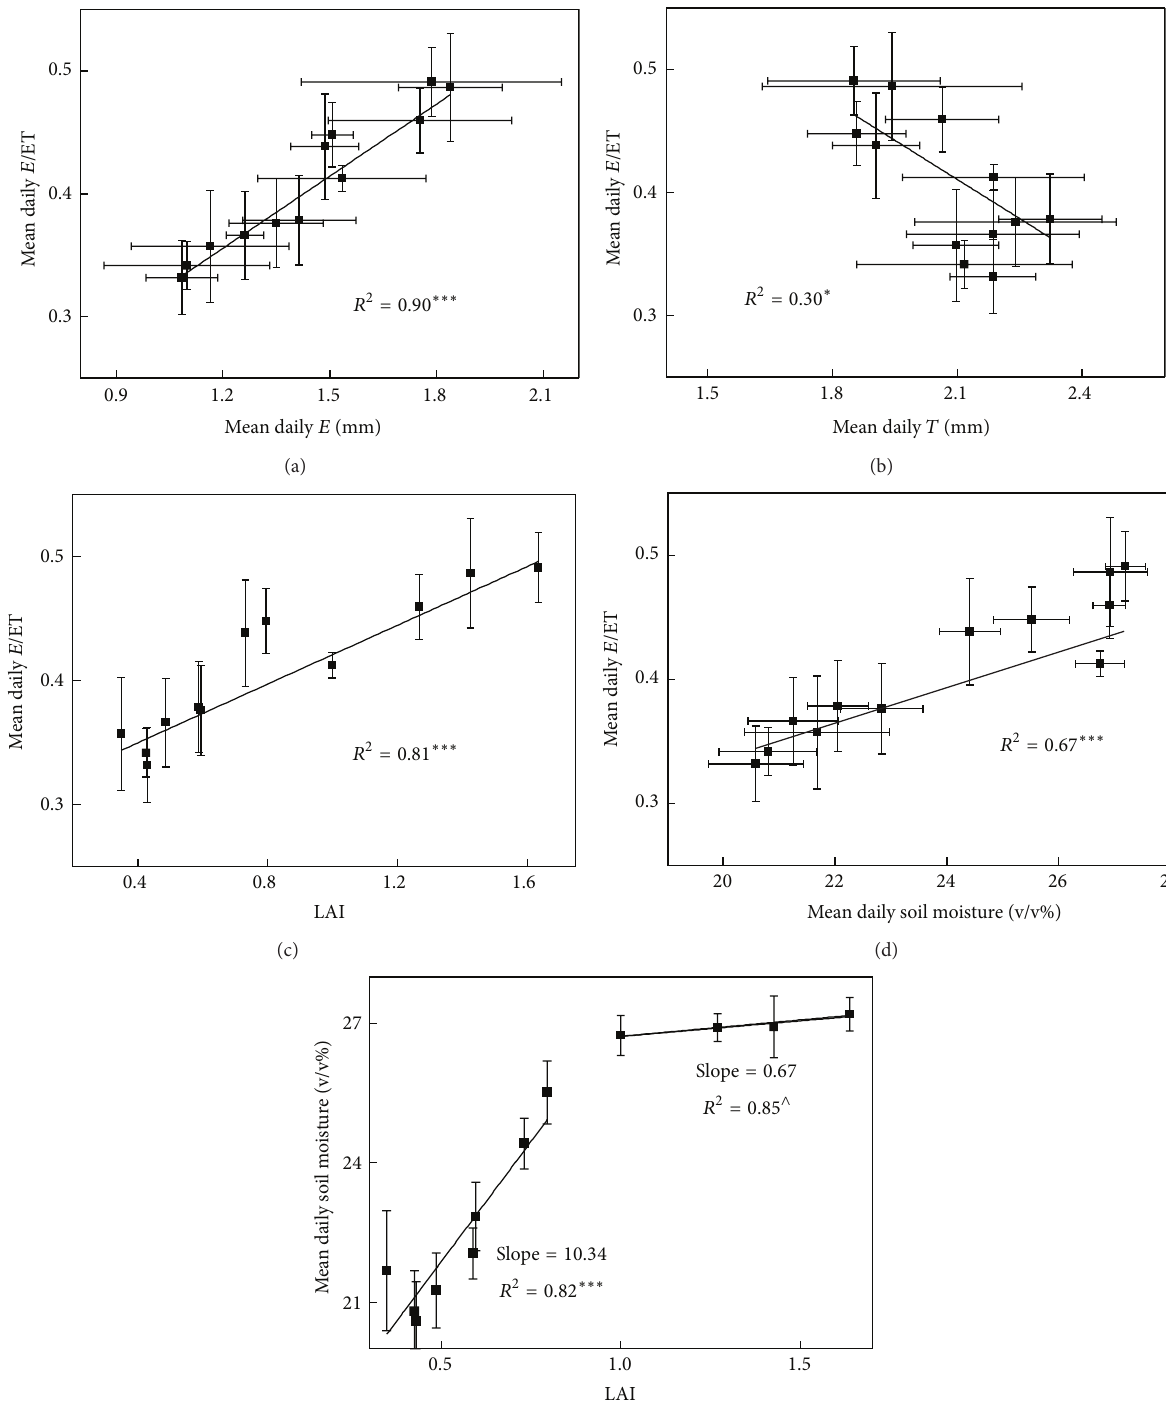
Figure 7: Relationships between mean daily E/ET and mean daily (a) E, (b) T, (c) LAI, and (d) soil moisture and (e) the relationship between LAI and mean daily soil moisture. ∧ 𝑃 > 0.05 ; ∗ 𝑃 < 0.05 ; ∗∗ 𝑃 < 0.01 ; ∗∗∗ 𝑃 < 0.001